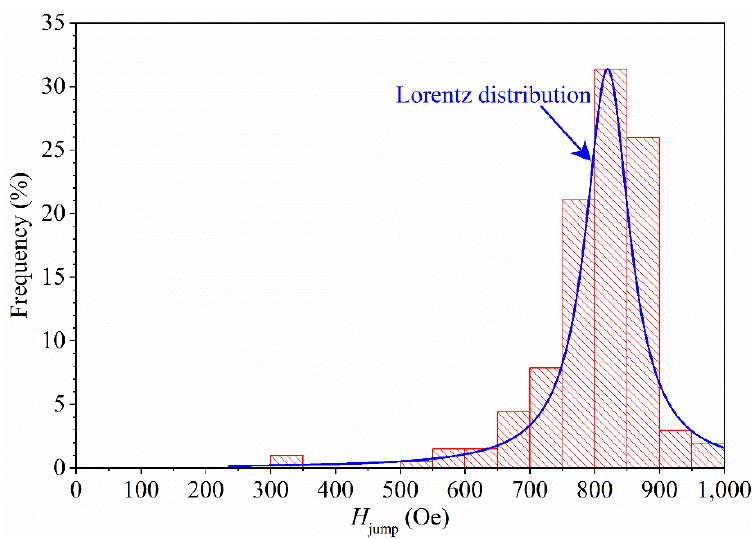
Figure 5. Distribution of the H jump values. The blue curves represent the fit of the data with a Lorentz distribution curve. The event at approximately H jump = 320 Oe is an outlier of the distribution and is present only in the measurement at lowest temperature.